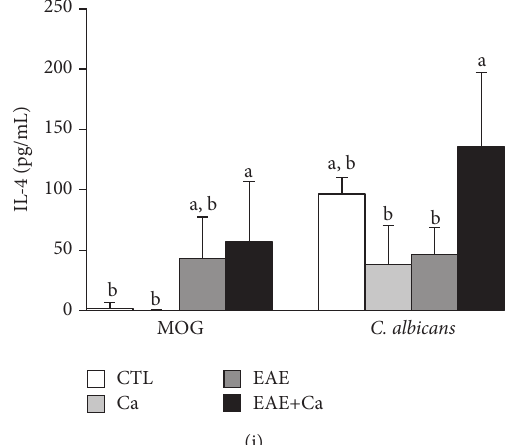
Figure 4: Modulation of MOG-induced cytokine production by previous infection with C. albicans . C57BL/6 mice were infected with C. albicans and 3 days later they were submitted to EAE induction. Fourteen days after EAE induction, some immunological parameters were evaluated in the spleen. The percentage of CD3 + CD4 + (a) and CD3 + CD4 + CD25 + FoxP3 + (b) was performed by cytometric analysis in 100.000 acquired events. IL-10 (c), TNF- 𝛼 (d), IL-6 (e), IL-17 (f), IFN- 𝛾 (g), IL-2 (h), and IL-4 (i) levels were measured in spleen cell cultures stimulated with MOG or heat-killed C. albicans . The results are expressed as mean ± SD ( 𝑛 = 6 – 8 mice/group). ANOVA, Tukey’s test, and 𝑃 < 0.05 . Different letters indicate statistical difference among the groups (a and b) or among the groups under the same in vitro stimulation (c, d, e, f, g, h, and